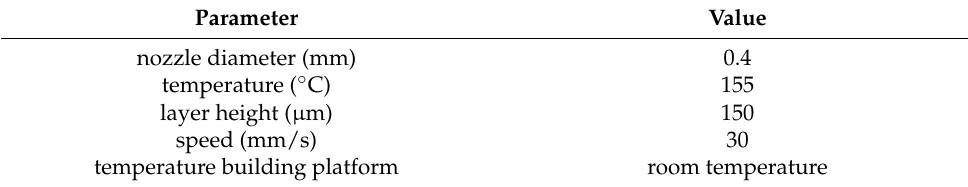
Table 2. Used parameters for FFF.